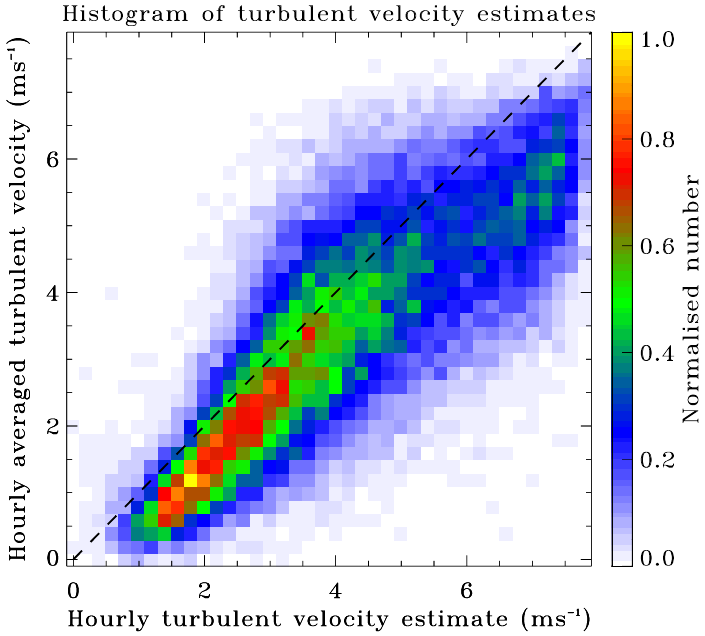
Fig. 9. Scatter plot of hourly averaged 2-min IDI turbulent velocities vs. hourly IDI turbulent velocity estimates over the entire observation period. The dashed line indicates